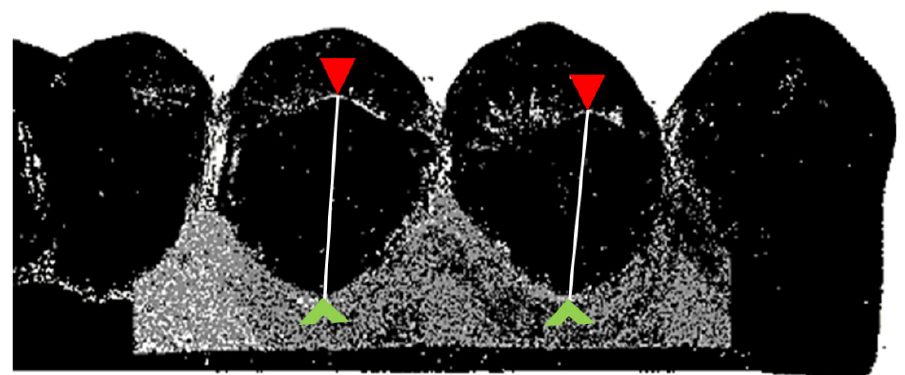
Figure 4. Marginal gingiva height change analysis. Schematic view of distance measurement for the marginal gingiva height change analysis (palatal aspect of upper premolars). Red arrowhead points to the highest point of the palatal cusp tip, green arrowhead points to the deepest point of the palatal marginal gingiva.